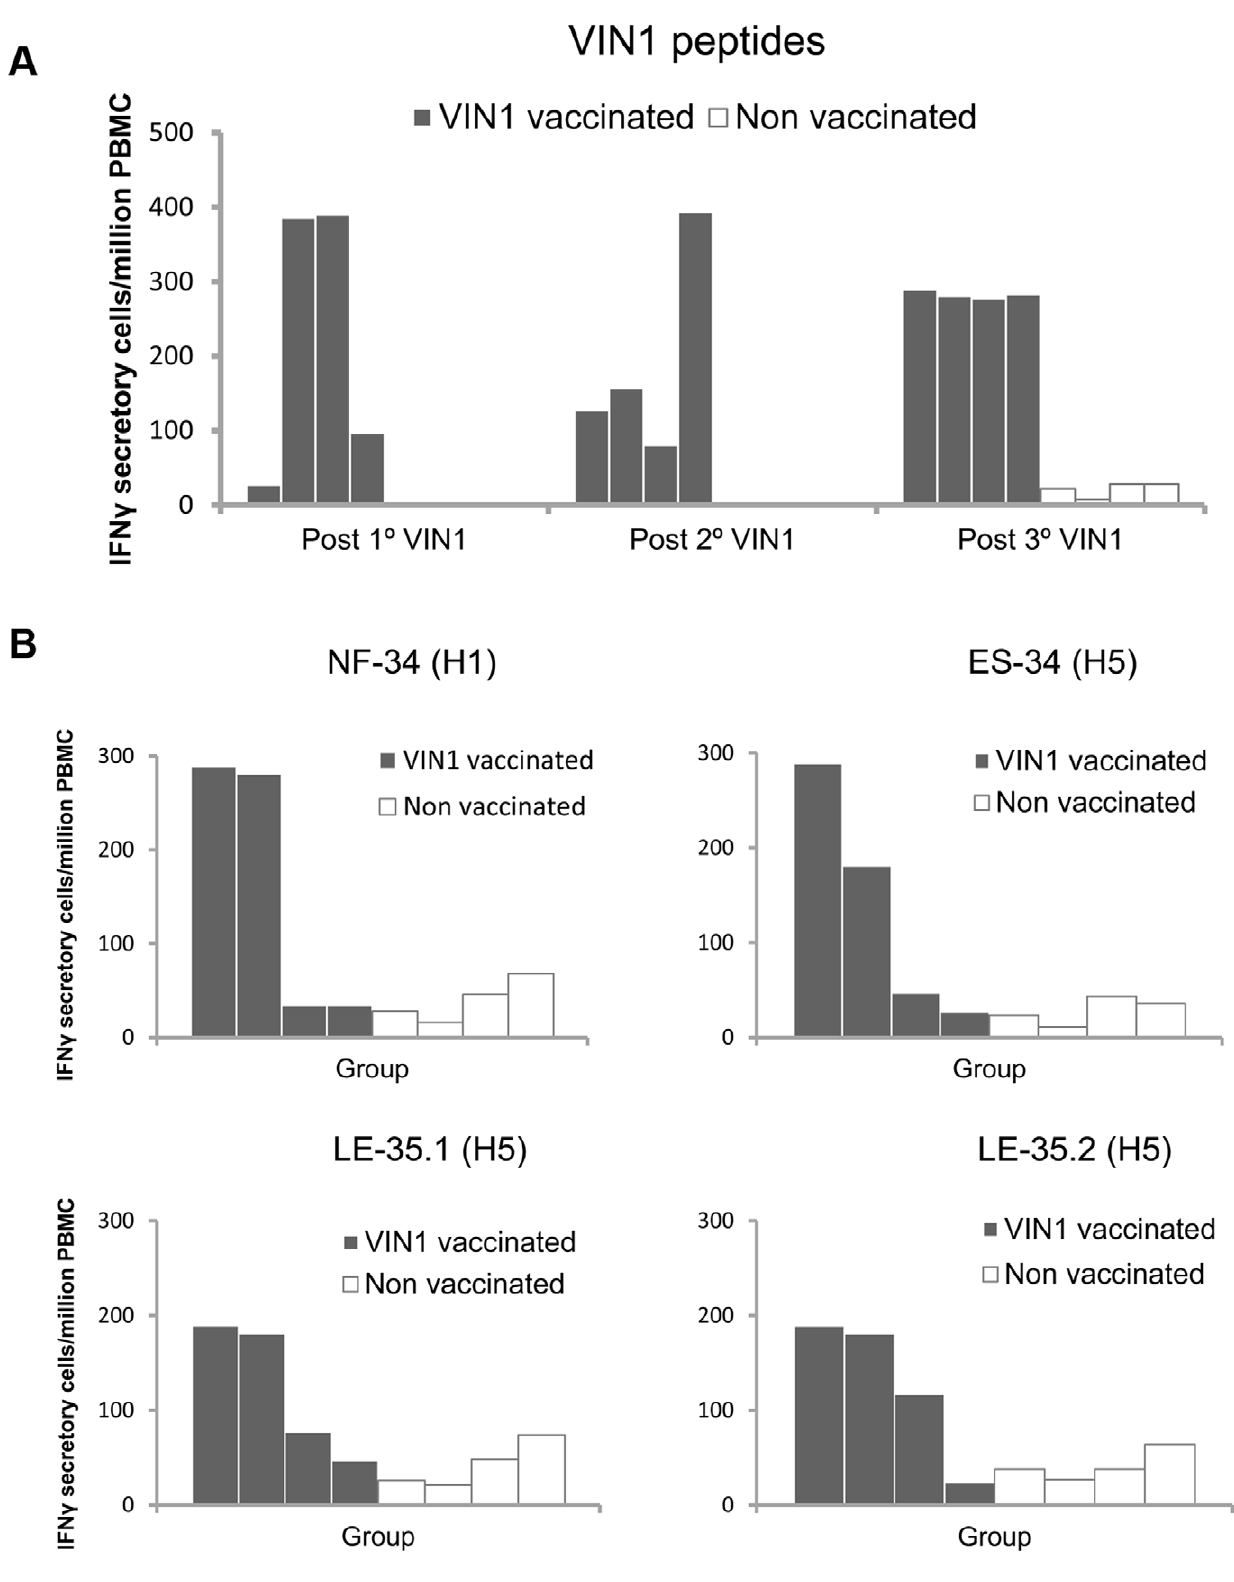
Figure 2. VIN1-HA1 derived peptides immunization induces strong T-cell responses in pigs. (A) Kinetics of the VIN1 peptide-specific T- cell responses induced 15 days after all immunizations measured by IFN c -ELISPOT. (B) Specific T-cell responses induced 4 weeks after the third immunization were tested for each single peptide by IFN c -ELISPOT.